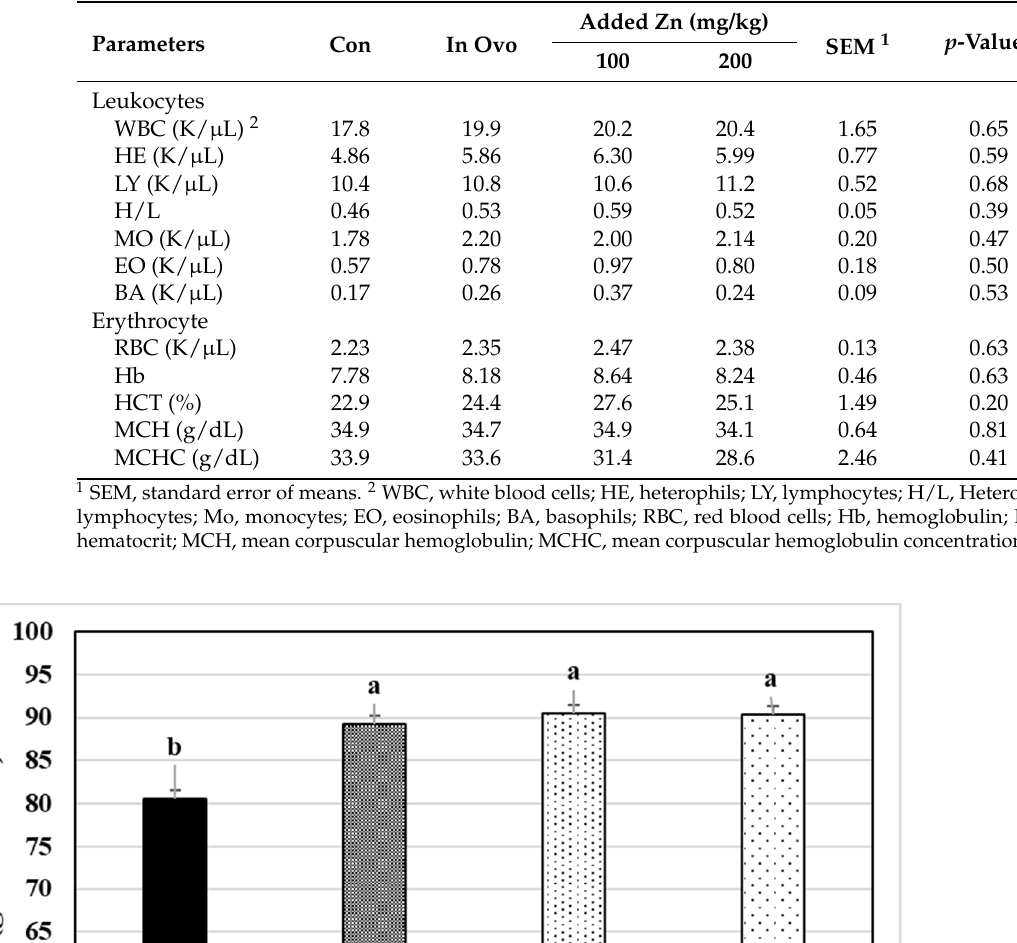
Table 5. Effect of in ovo injected and supplemental Zn breast meat quality in broilers at 35 days of age.